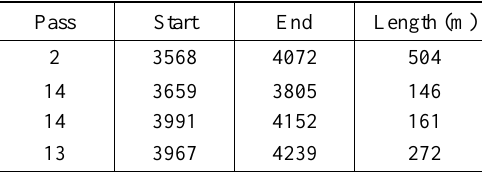
Table 2. Periods where passes were omitted The NIMBUS software automatically determines a weighted average for each point on the control polyline. Corrections are then determined and applied to the trajectory of each pass so that the profile extracted from the new point cloud produced will align with the CP. The mapping from the linear space of the CP to the time-related trajectories also provides a degree of smoothing of the data. The procedure is repeated and the corrected profiles for each pass are evaluated against the CP to ensure they are in agreement (Figure 9).